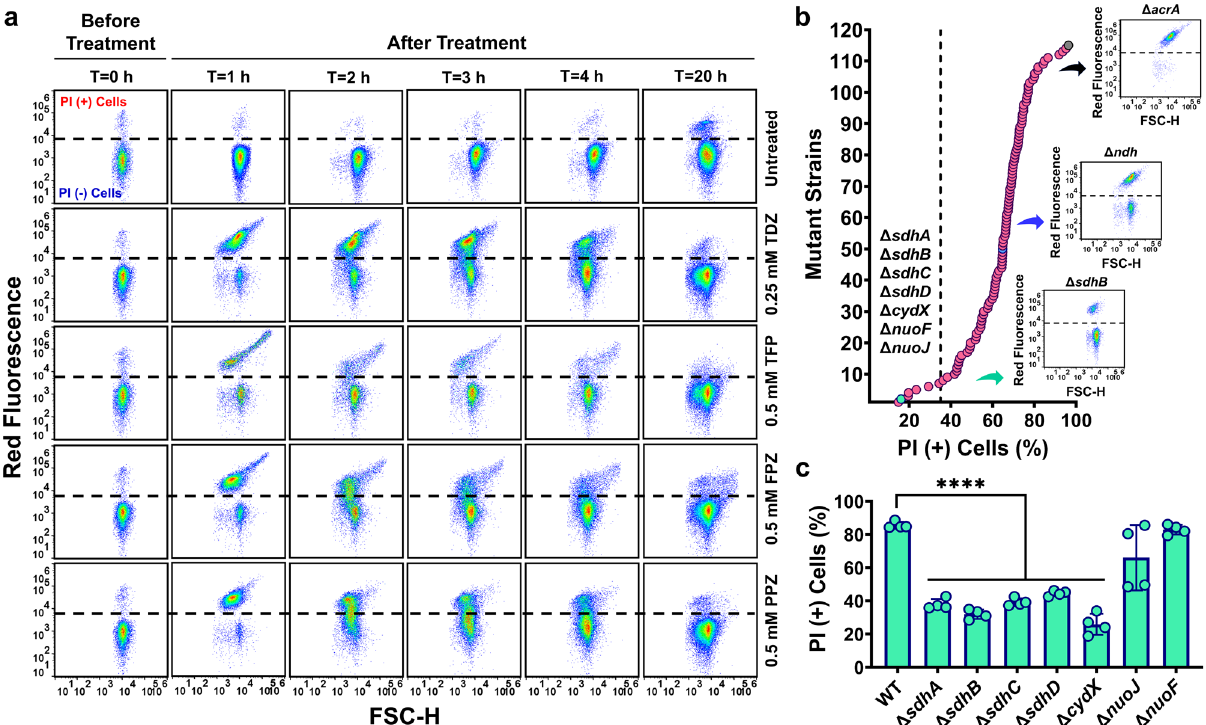
Fig. 6 Phenothiazine can transiently permeabilize the cell membrane by inhibiting membrane-bound metabolic proteins. a Phenothiazine treatment induced membrane permeabilization. E. coli MG1655 cells at early stationary phase (grown in LB) were treated with phenothiazine drugs at indicated concentrations. Following treatment, samples were collected and stained with PI at indicated time points for fl ow cytometry analysis. Live cells and ethanol- treated dead cells were used as negative and positive controls, respectively, to gate the PI negative ( − ) and PI positive ( + ) populations (see Supplementary Fig. 8b). n = 3. b Screening E. coli (K-12 BW25113) Keio Knockout Collection. Cells at early stationary phase (grown in LB) were treated with 0.25 mM TDZ for 1 h and then stained with PI for fl ow cytometry analysis to quantify PI ( + ) cell fractions (%). n = 1. c Phenothiazine-induced membrane permeabilization in E. coli MG1655 mutant strains. The mutant strains at early stationary phase were treated with 0.25 mM TDZ for 1 h and then stained with PI for fl ow cytometry analysis. n = 4. Statistical analysis was performed using one-way ANOVA with Dunnett ’ s post-test. **** P < 0.0001. FSC-H: Forward scatter. Data corresponding to each time point represent mean value ± standard